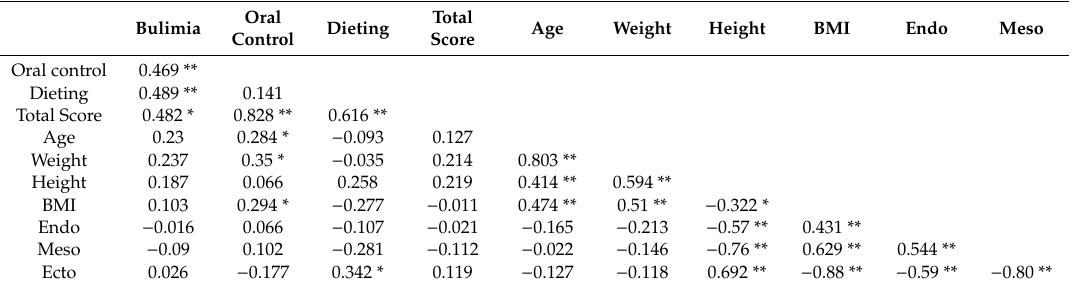
Table 3. Spearman’s rank correlation coefficients between body composition variables, somatotype components, and the EAT-26 subscales in the Advanced Training group.